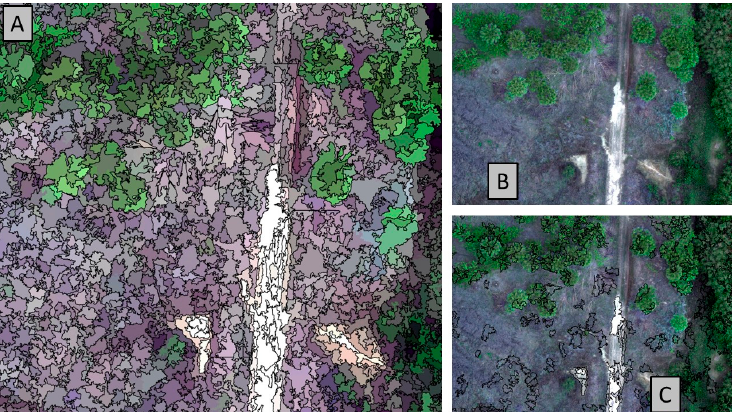
Figure 8. Image segmentation results ( A ) polygons delimitating the segmented objects ( B ) RGB orthoimage, ( C ) polygons used as training samples during the model training process. Training data was extracted for every band combination, Table 6. The 3094 training sample polygons were used to train the RF and SVM algorithms (see next section). The same training polygons were used to create training tiles (256 × 256 pixels) from the im- ages with a 128-pixel stride and 30° rotation angles to train the deep learning networks (U-Net and DeepLabv3, see next section), Figure 9. The stride and rotation features were used to augment the training data. Training tiles were only retained for the instances where the polygons and tiles overlapped, resulting in a final set of 27,948 training tiles.